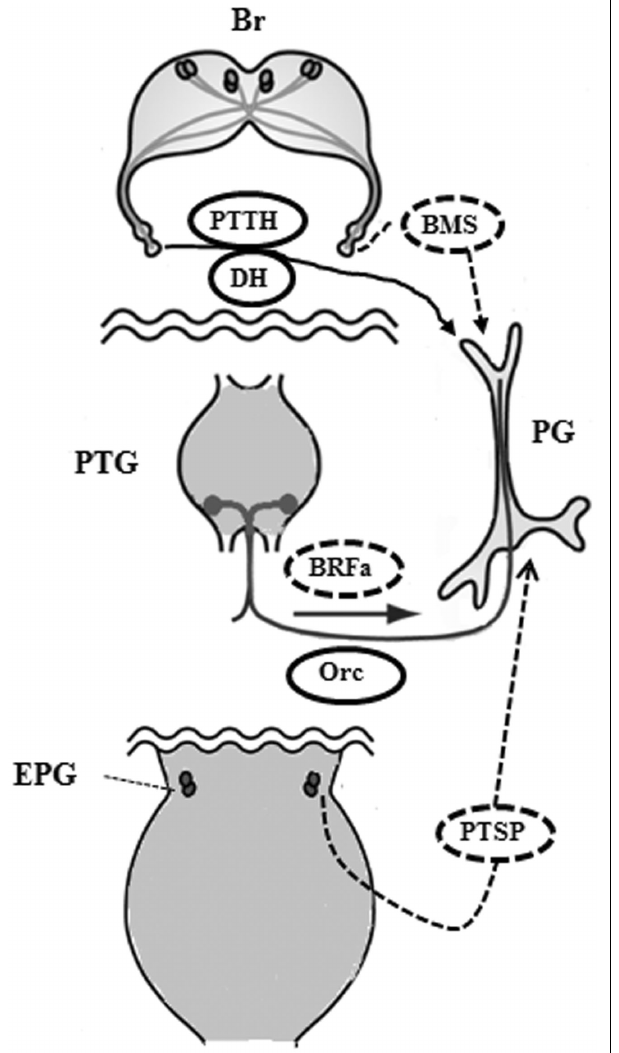
FIGURE 2 | Proposed regulatory mechanism of ecdysteroidogenesis by the prothoracic gland in the larva of Bombyx mori . During the feeding stage, BRFa and orcokinin are delivered through the innervating neurons to maintain low levels of ecdysteroid in collaboration with circulating BMS. Next, PTTH and DH are released to stimulate ecdysteroidogenesis after the release of inhibition by BRFa and BMS. PTSP is secreted from the epiproctodeal gland after the ecdysteroid level reaches a peak in order to decrease ecdysteroid levels rapidly. Br, brain; PTG, prothoracic ganglia; PG, prothoracic gland; EPG, epiproctodeal gland; Orc, orcokinin. Solid ovals indicate tropic factors and dotted ovals indicate static factors.